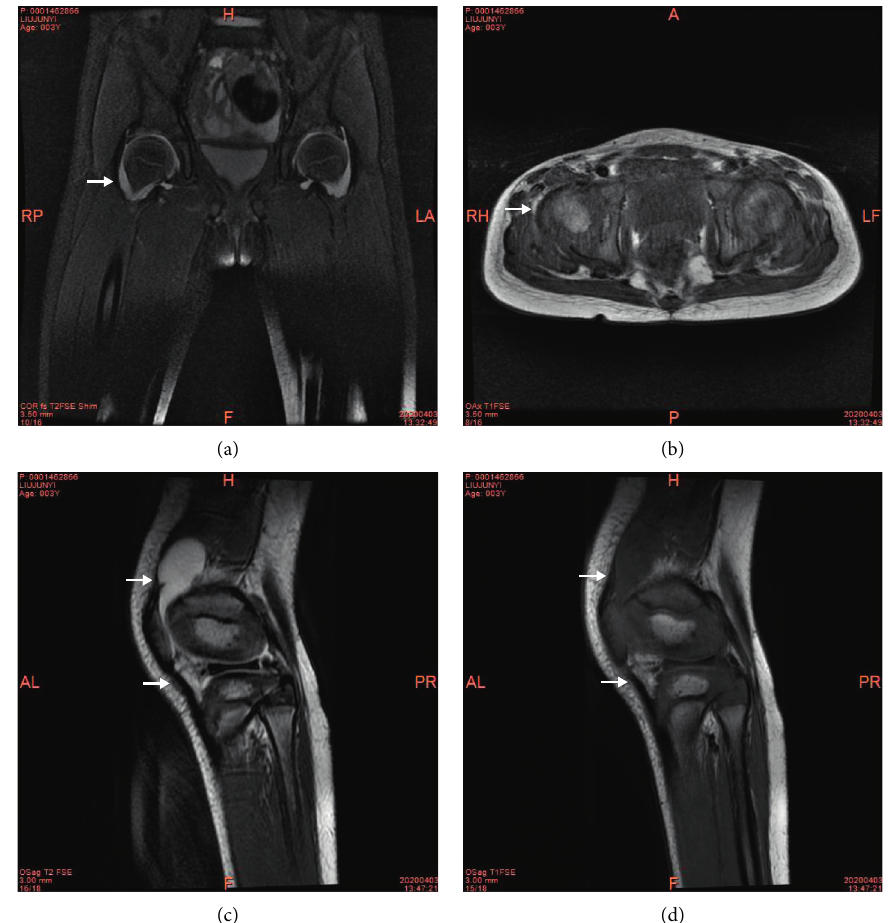
Figure 1: T1-weighed, T2-weighed, and Fat-suppressed T2-weighted imaging in the acute phase of Kawasaki disease. There were a long T1 signal and long T2 signal in the bilateral hips (a), (b), knees, and bursae suprapatellaris (c), (d), which indicated arthritis with